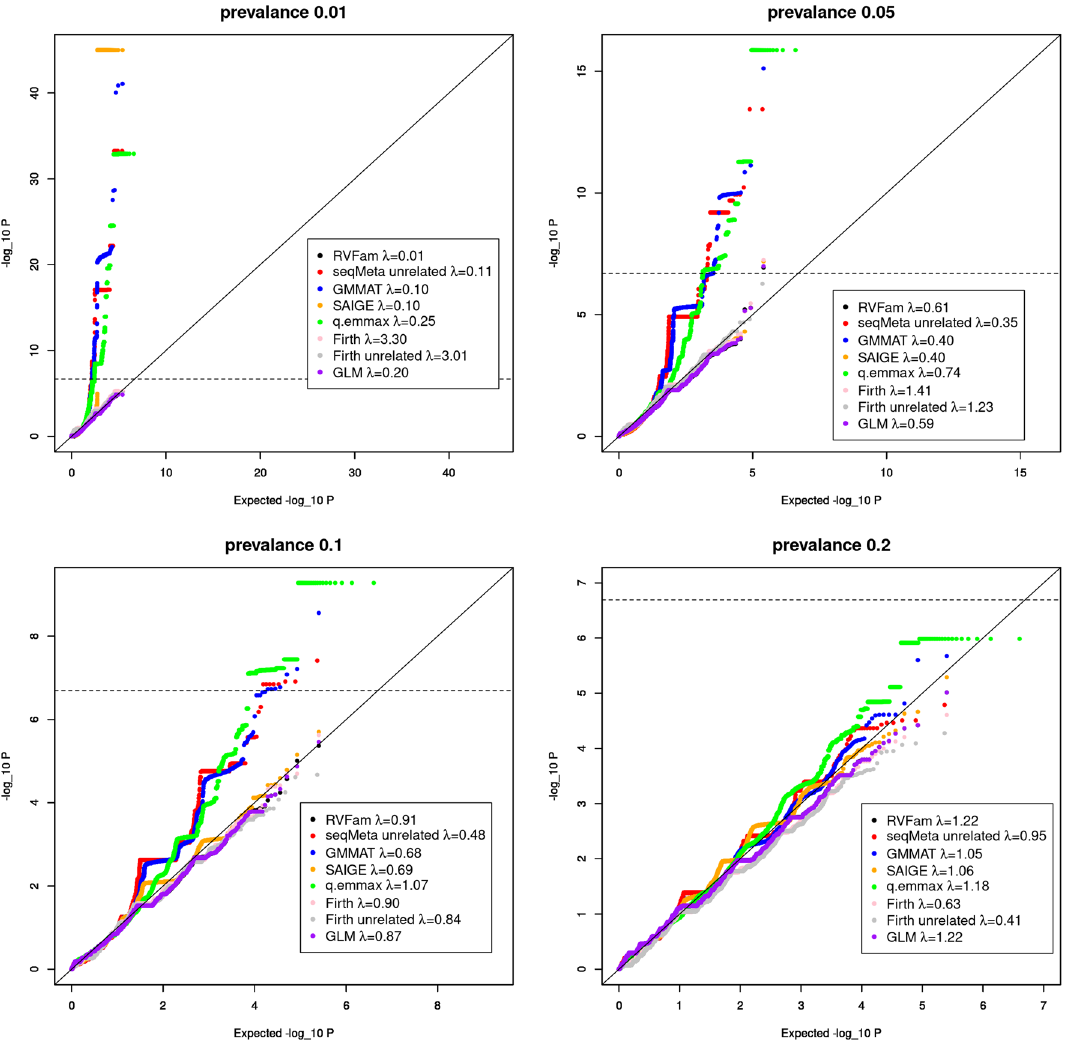
Figure 1. QQ plots of replicate 1 for assessing Type I error inflation in single variant tests (SVT) of the first simulation